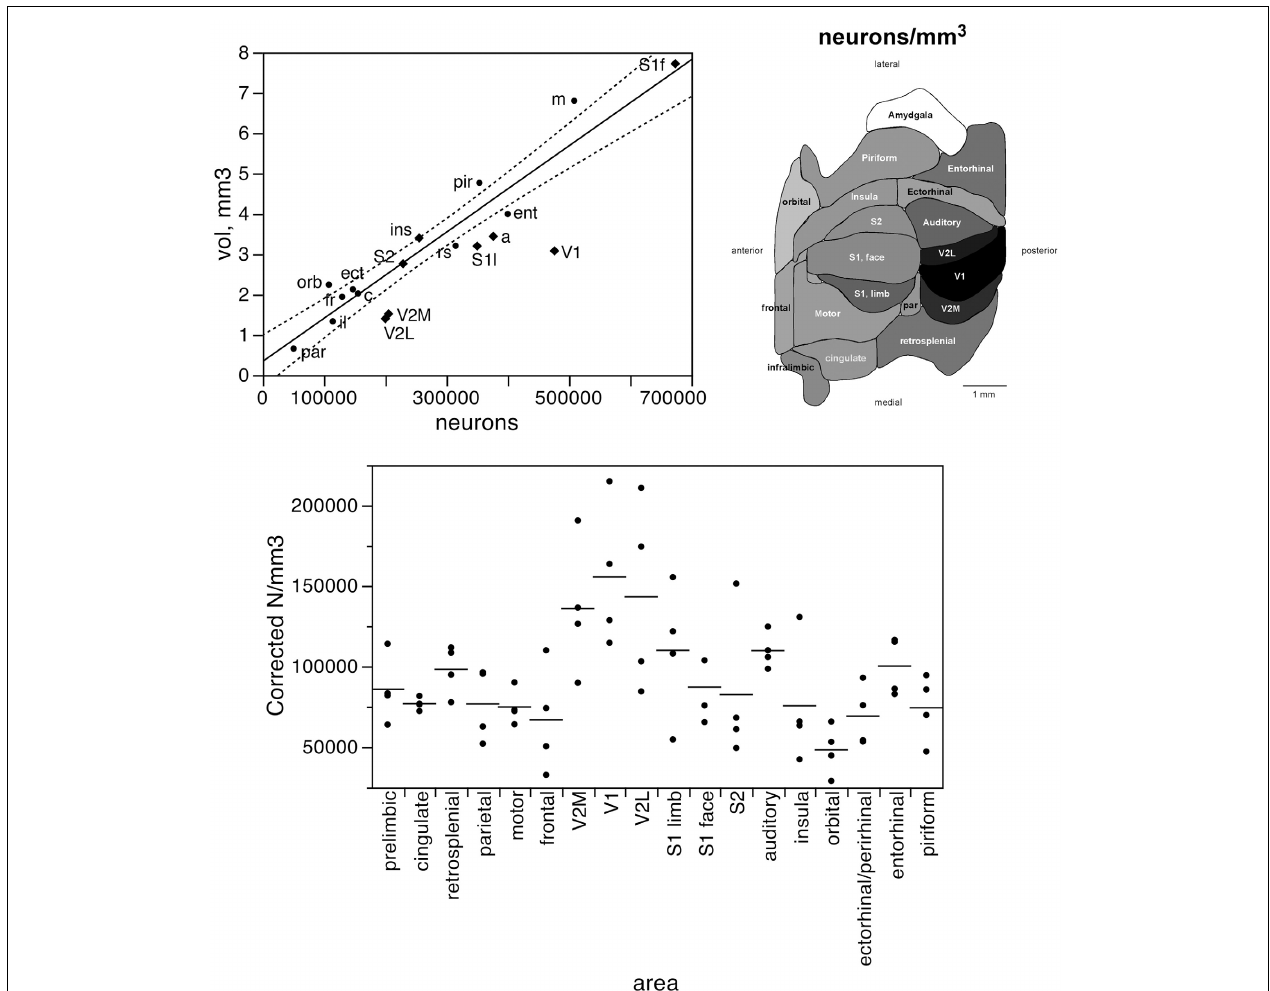
FIGURE 2 | The volume of each functional area varies as a simple shared function of the number of neurons in each area, with the exception of the visual areas. Top left, area volume plotted as a function of the average number of neurons found in that functional area. The fitted line is the linear function that describes the entire dataset, including areas V1, V2L, and V2M, whose respective datapoints fall well outside of the 95% confidence interval